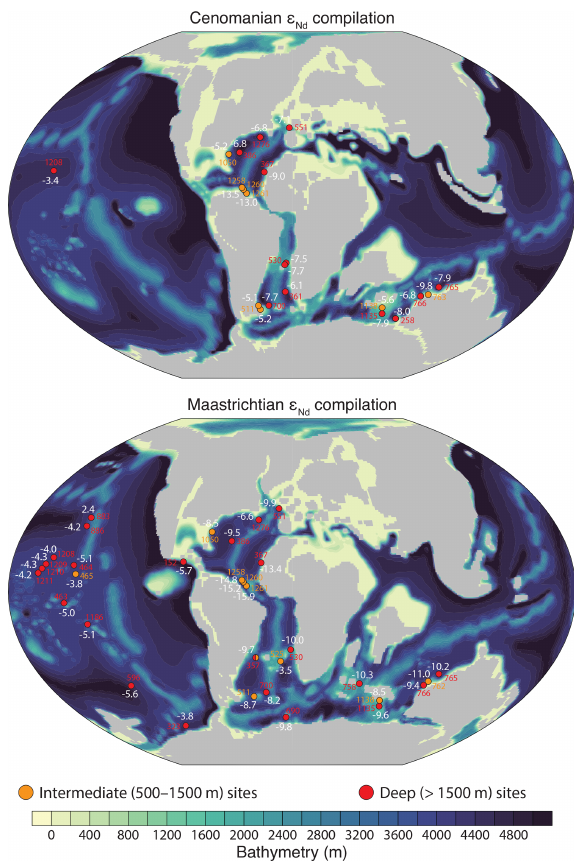
Figure 13. Cenomanian and Maastrichtian ε Nd compilation mod- ified from Moiroud et al. (2016), with few additions (Tables S3 and S4). The ε Nd values at each site are averaged between 100 and 90Ma for the Cenomanian and between 75 and 65Ma for the Maas- trichtian. Site numbers are shown for